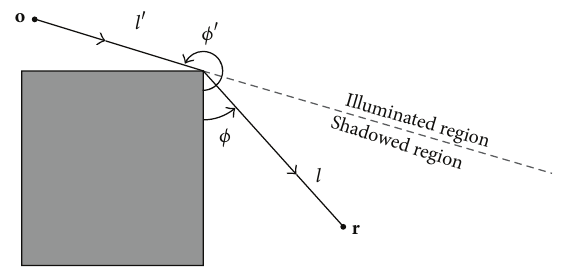
Figure 1: Configuration for the scattering